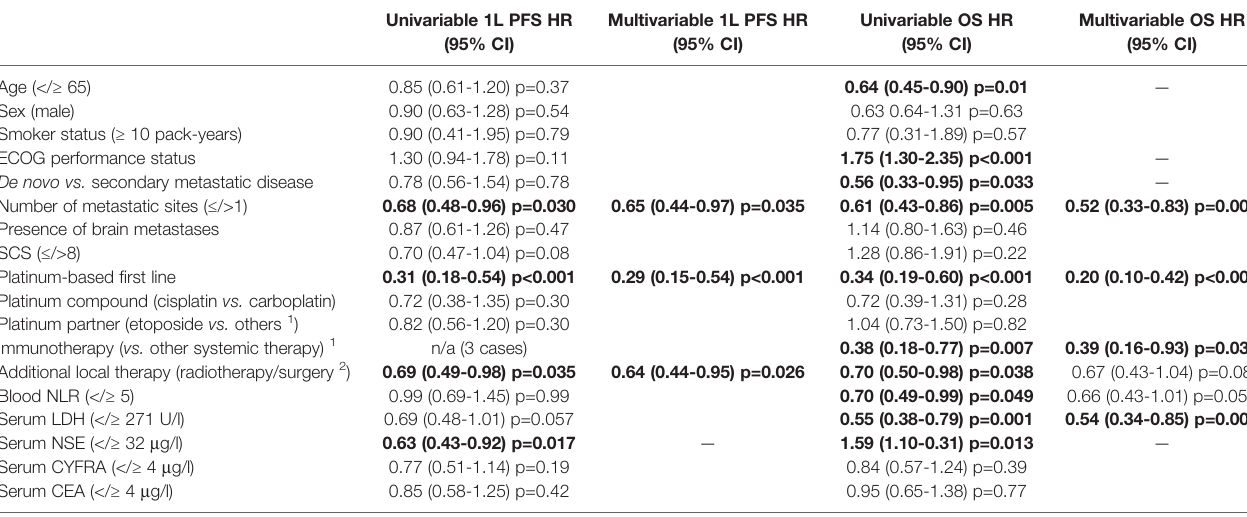
TABLE 2 | Progression-free and overall survival of patients with metastatic LCNEC without treatable